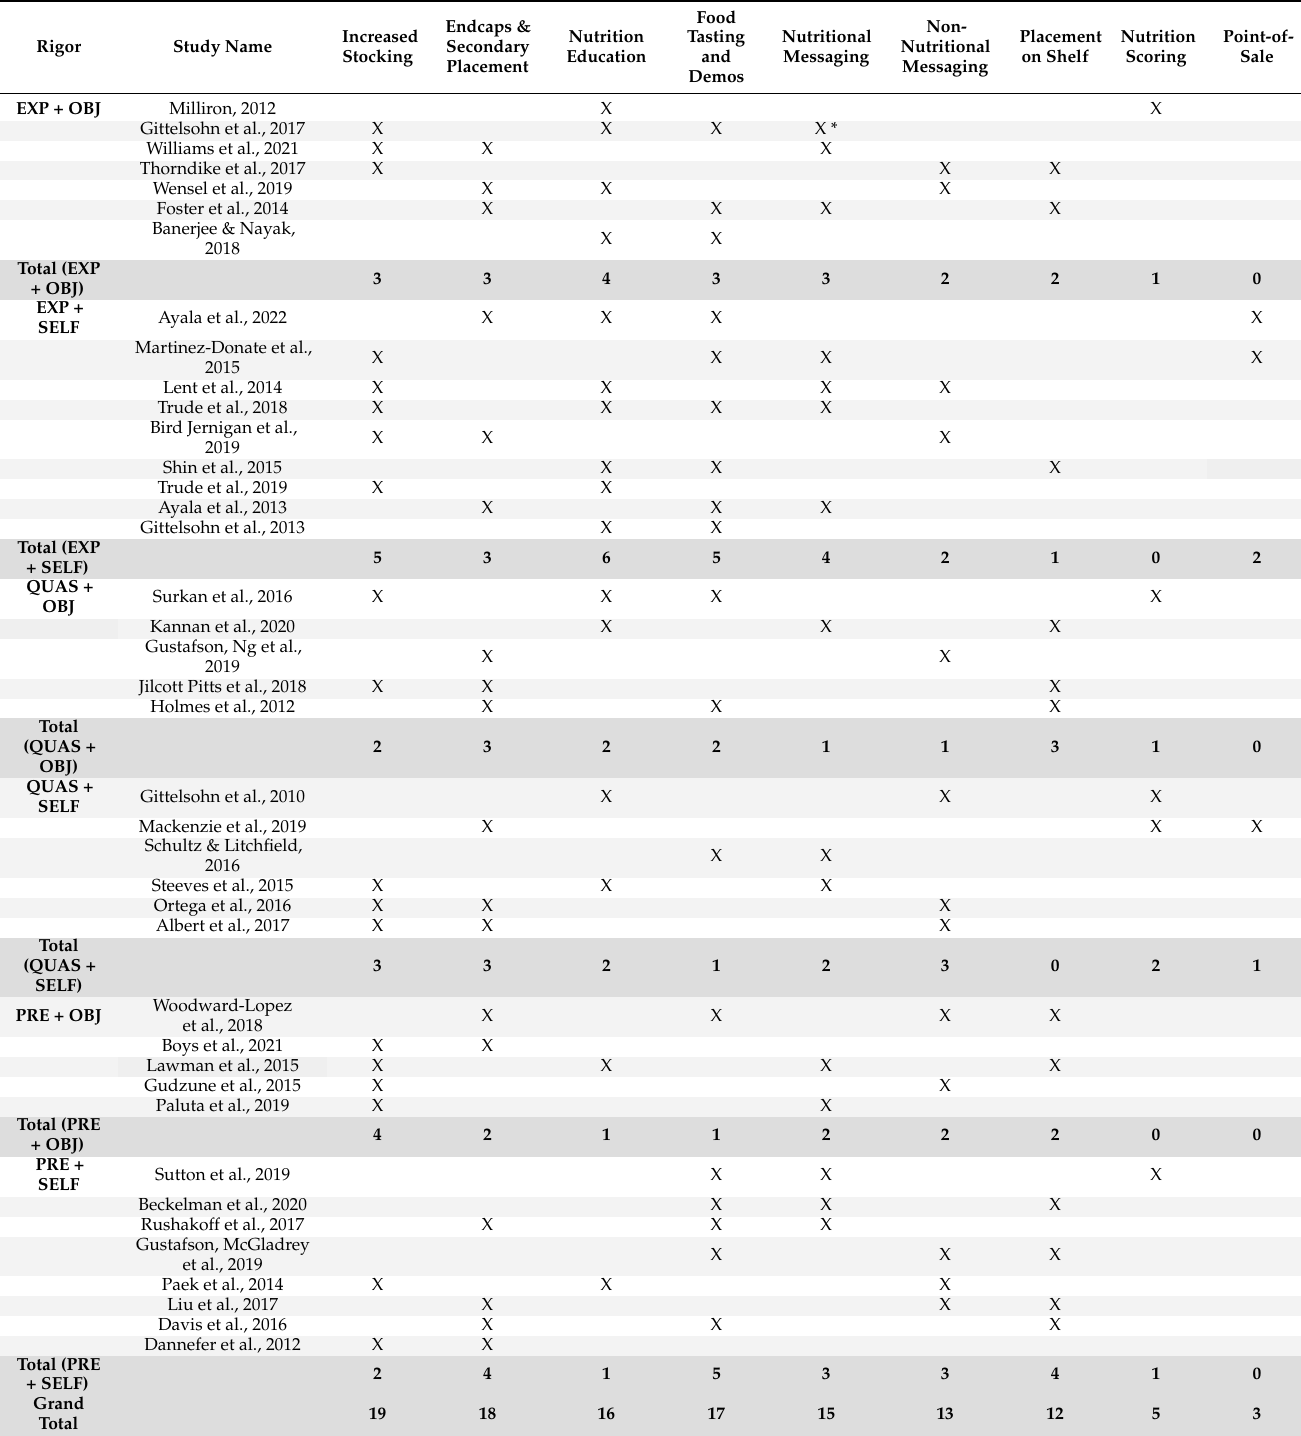
Table 3. Intervention Types in Multi-Component